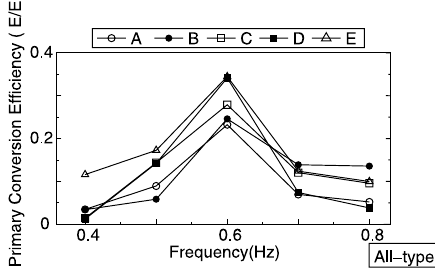
Fig. 10 Frequency Response of Power Output Ratio for five types